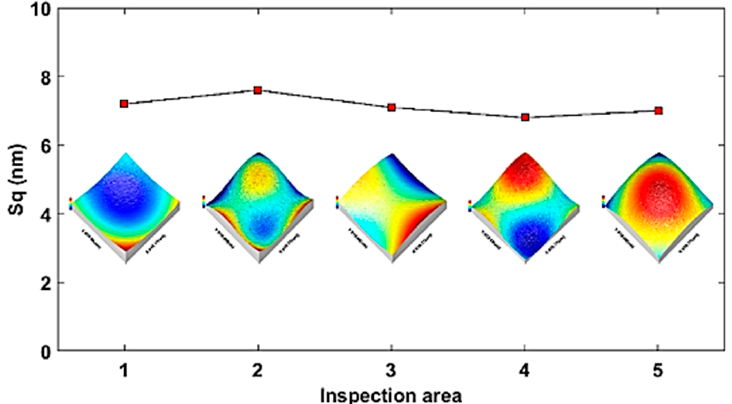
Figure 21. Topography distribution of sinusoid grid surface.